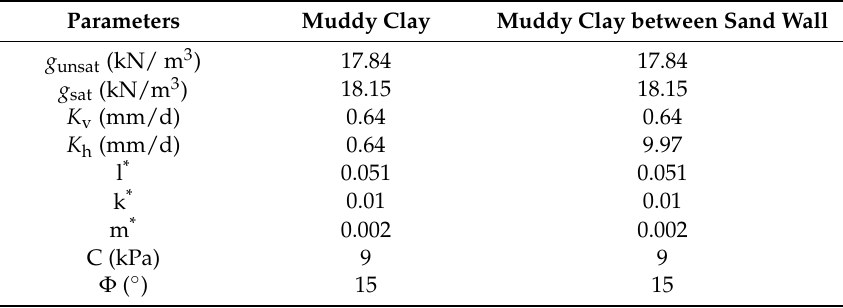
Table 6. The soft soil creep model parameters.